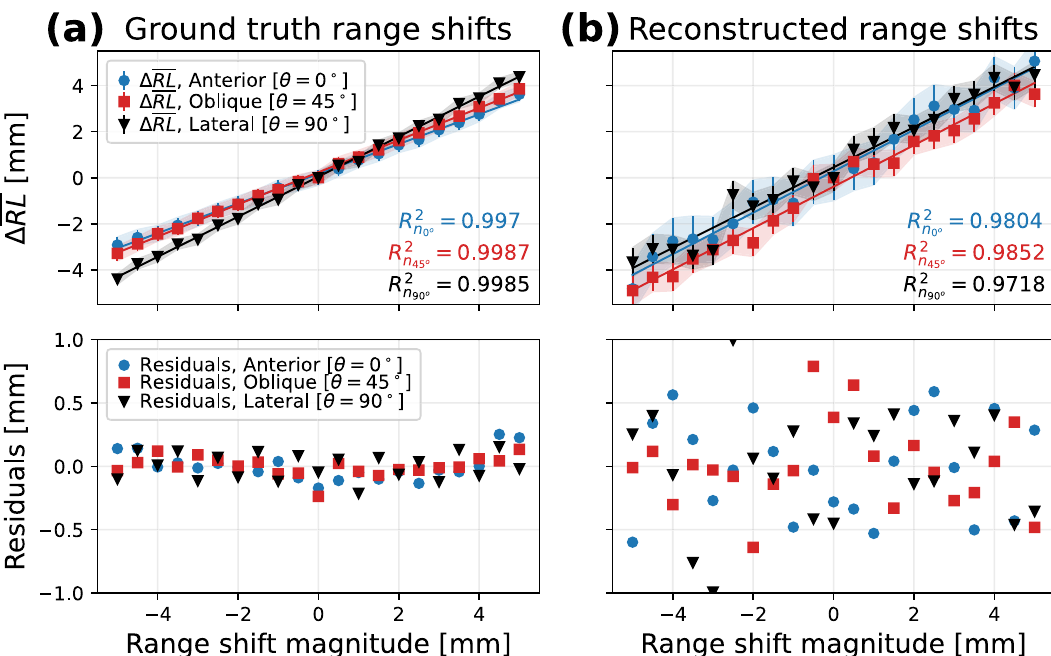
Figure 4. The correlation between the true range shifts and (cid:31) RL . ( a ) Shows the true range shifts against the mean of the calculated range shifts, (cid:31) RL , from the true distributions of detected FNs. ( b ) Shows the true range shifts against (cid:31) RL from the reconstructed distributions of detected FNs along with the residuals. For both ( a ) 8 and ( b ), (cid:31) RL are calculated for a proton intensity of 10 protons/spot. Use of the true distributions predicts a nearly perfect linear relationship between the true range shifts and (cid:31) RL . The same can be said to be true for the relation between the true range shifts and (cid:31) RL values estimated from the reconstructed distributions in spite of increased fluctuations reflected in the lower panel showing the